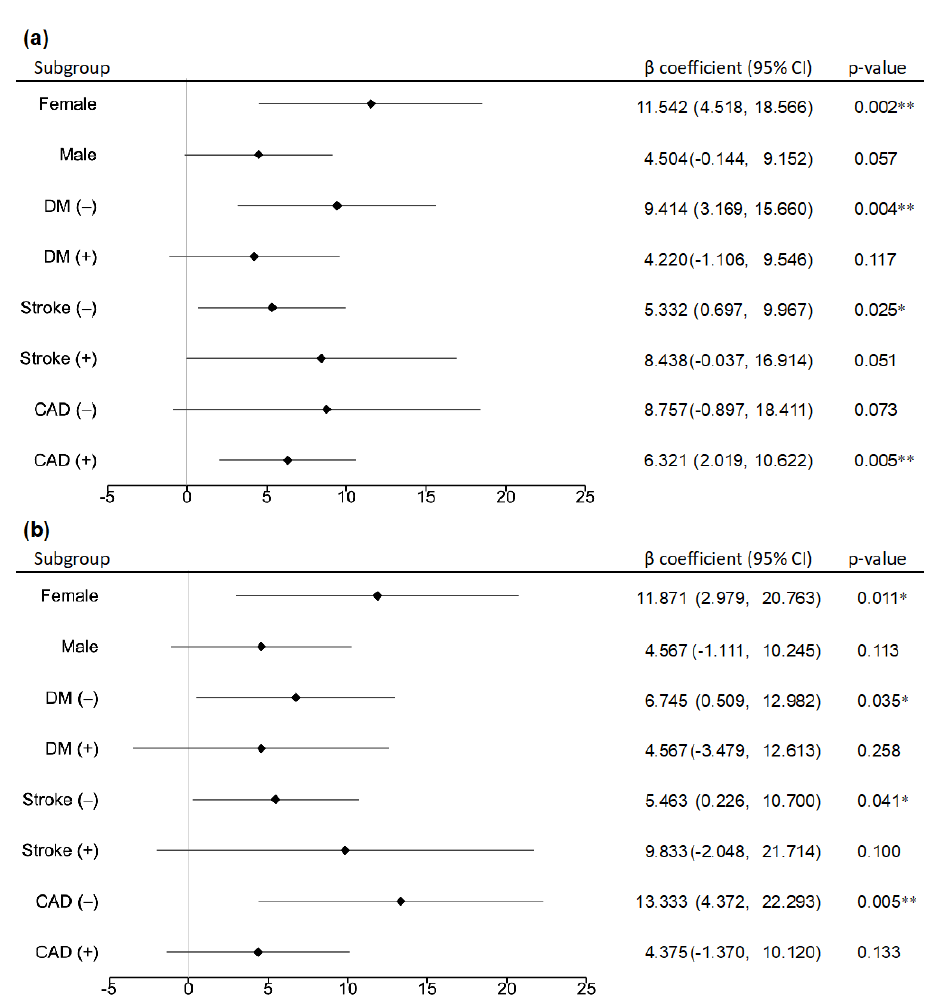
Figure 2. Subgroup analysis of the association between ( a ) ABI/( b ) TBI and MoCA-J score. The black diamond-shaped symbols represent β coefficients (partial regression coefficients), and the black bars indicate 95% confidence intervals. ABI: ankle brachial pressure index, TBI: toe brachial pressure in- dex, MoCA - J: the Japanese version of the Montreal Cognitive Assessment, DM: diabetes mellitus, Stroke: cerebral hemorrhage and cerebral infarction, CAD: coronary arterial disease , * p < 0.05, ** p < 0.01.